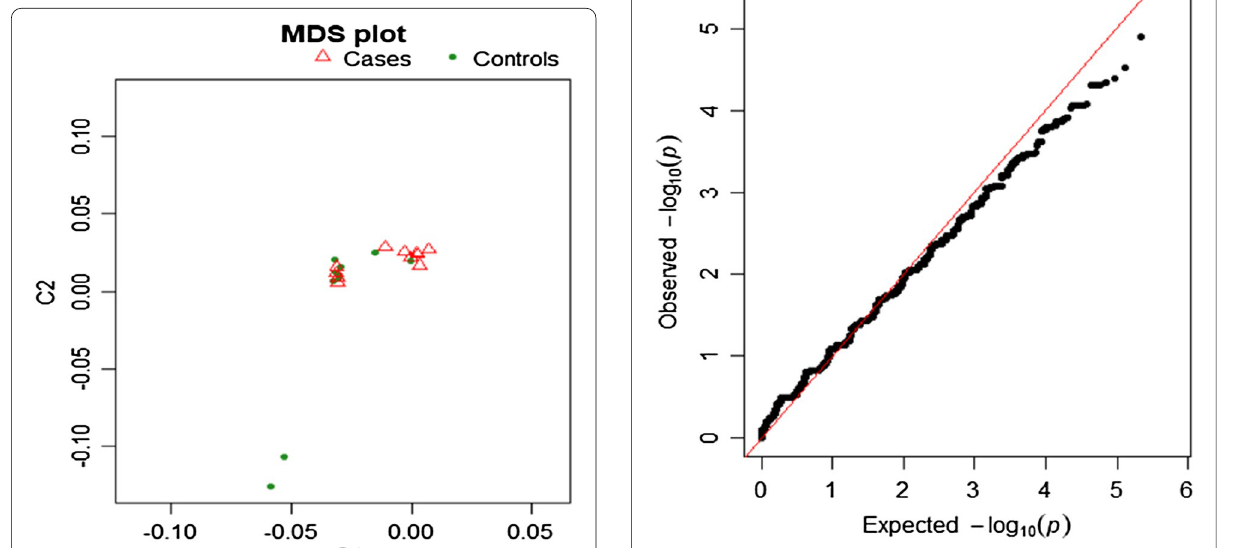
log 10 of p -values −